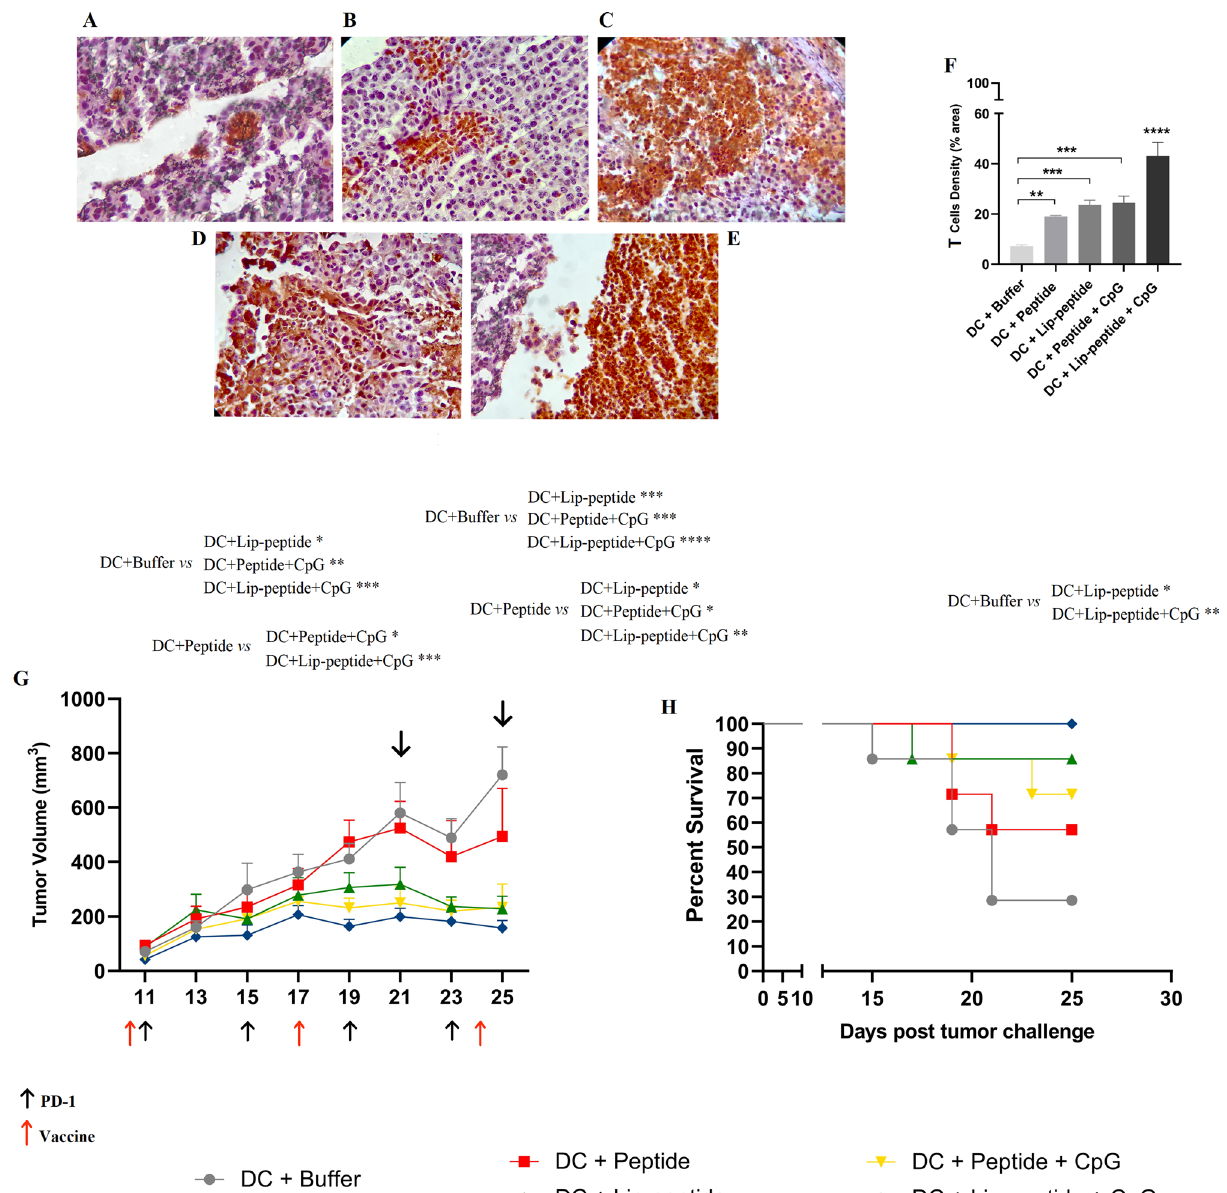
Figure 6. T cell infiltration and Therapeutic efficacy of different ex vivo DC-based vaccination groups in combination with PD-1 blockade in B16F10 melanoma model. Representative IHC results of tumor sections with different intensities of PD-1 staining. T cells, either clustered or dispersed, are stained dark brown. Images of tumor section from ( A ) DC + Buffer, ( B ) DC + Peptide, ( C ) DC + Lip-peptide, ( D ) DC + Peptide + CpG-ODN and ( E ) DC + Lip-peptide + CpG-ODN, Scale bars, 50 µm. ( F ) T-cell densities (mean ± SD, N = 3) as percentage of anti-PD-1-stained area against the total area. ( G ) Tumor growth curves of treated mice with tumor volume at any specific time point during treatment for a 25-day study period. This graph is also illustrating the timeline of vaccination and PD-1 therapy. P values correspond to tumor volume on days 21 and 25. Data are presented as mean ± SEM, N = 7. ( H ) Kaplan–Meier survival curve during 25 days therapeutic immunotherapy. The Log-rank test used for the significant difference between all combination groups (N = 7). P values correspond to survival rate on day 25. Statistically significant differences are shown as follows: * P < 0.05, ** P < 0.01, *** P < 0.001, **** P <